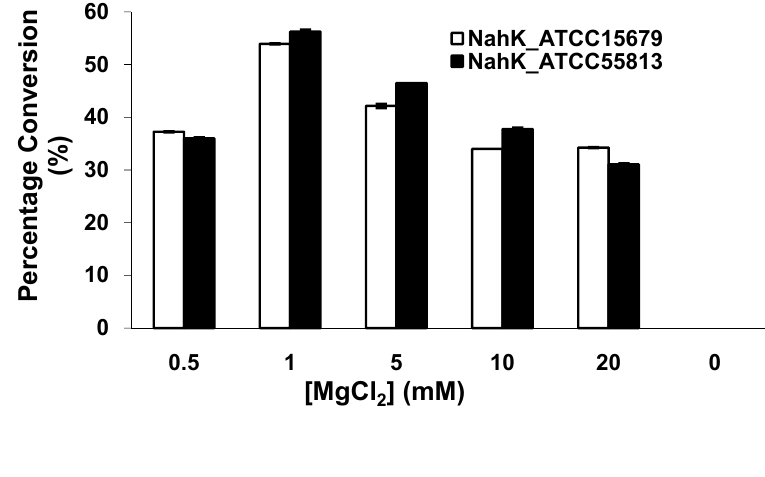
on the activities of NahKs. 2